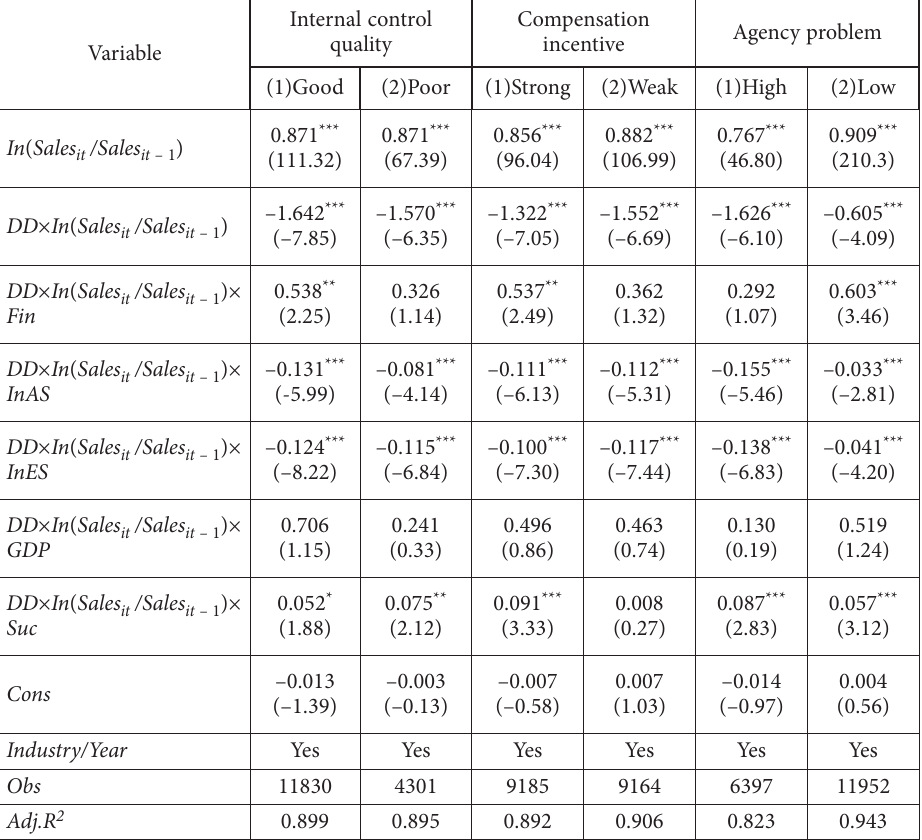
Table 5. Heterogeneous impacts